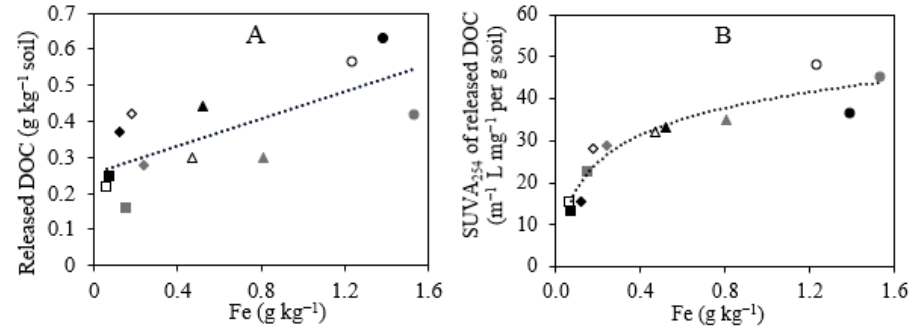
Figure 3. Regression relationship between the amount of released DOC ( A ) and SUVA 254 of DOC released ( B ) from soils after 0.5 N HCl at 0–10 cm (diamonds) and 10–25 cm (squares), 0.25 N HCl and 0.25 N NH 2 OH·HCl extraction at 0–10 cm (circles) and 10–25 cm (triangles) in hardwood forest (black fill), cropland with manure (gray fill), and continuous pasture (no fill). Panel A: Released DOC (g kg − 1 soil) = 0.19 × Fe (mg L − 1 ) + 0.16, r 2 = 0.54, p < 0.01; Panel B: SUVA 254 of released DOC (m − 1 ·L mg − 1 per g soil) = 9.27 × ln (Fe) (mg L − 1 ) + 39.84, r 2 = 0.89, p < 0.0001.